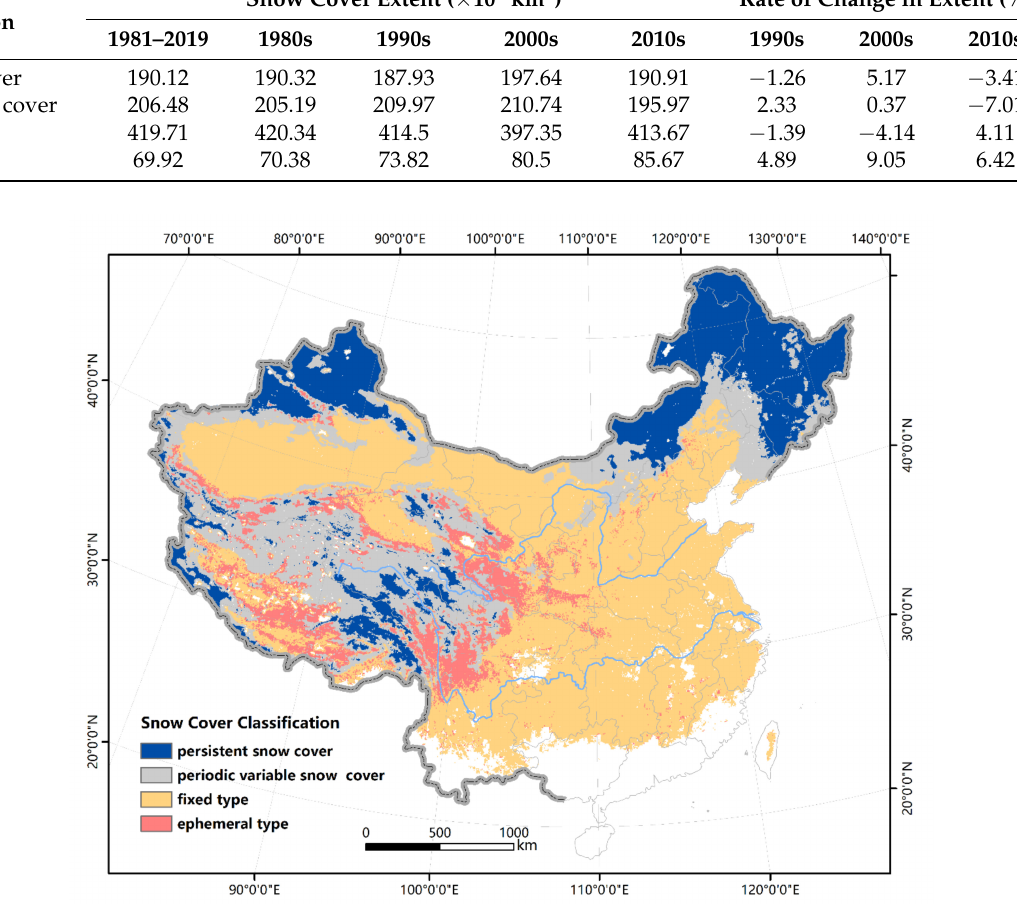
Snow Classification